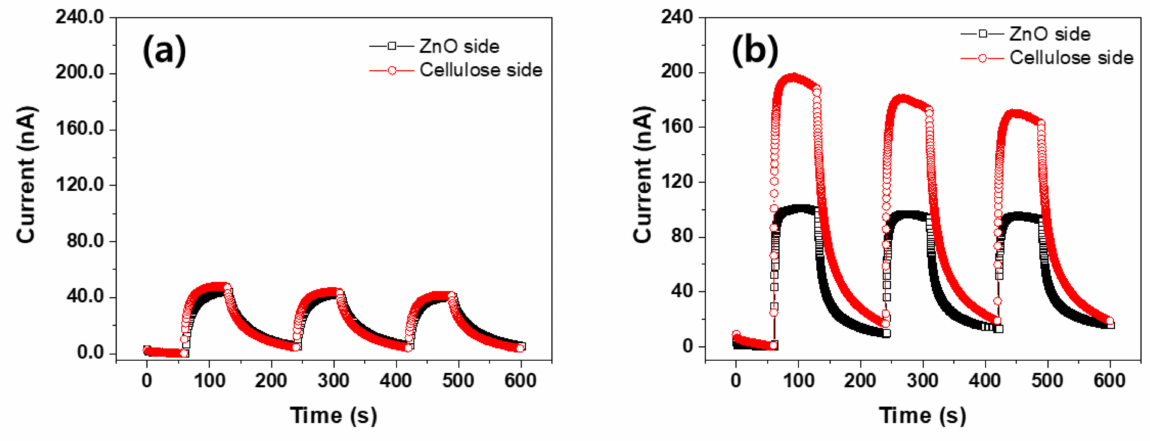
Figure 9. Current outputs of ZCNs with different UV irradiate sides: ( a ) 25 mM ZCN and ( b ) 50 mM ZCN. So far, Pt was coated on both sides of ZCNs to form electrodes. To investigate the electrode material effect on the UV sensing performance, a transparent electrode material, ITO, was coated on both sides of the ZCNs and compared with the Pt electrode. Figure 10 shows the current output of the 25 mM ZCN (a) and the 50 mM ZCN (b) for both electrode materials. Inset photographs show the images of the Pt- and ITO-coated ZCNs. Note that ITO is known to be transparent at 365 nm in contrast to Pt. Thus the